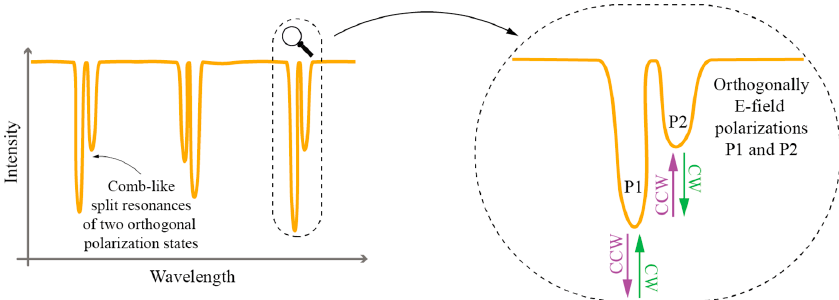
Figure 22. An example of forward propagating spectrum in excessively tilted FBG and its spectral response; ratio of dips P1 and P2 changes with fiber rotation (CW/CCW).